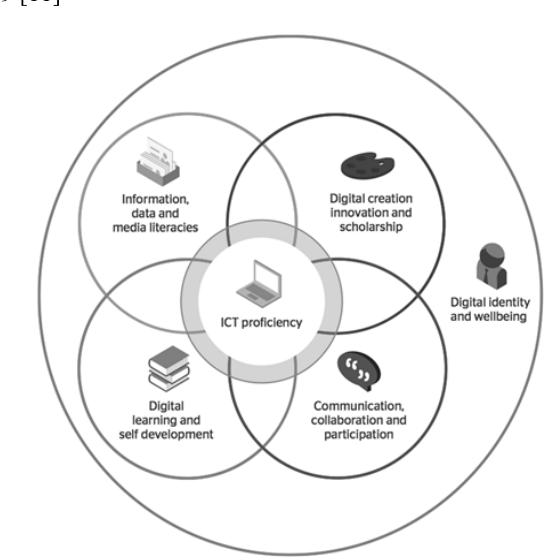
Figure 2 Digital capabilities framework and its six elements updated in 2015